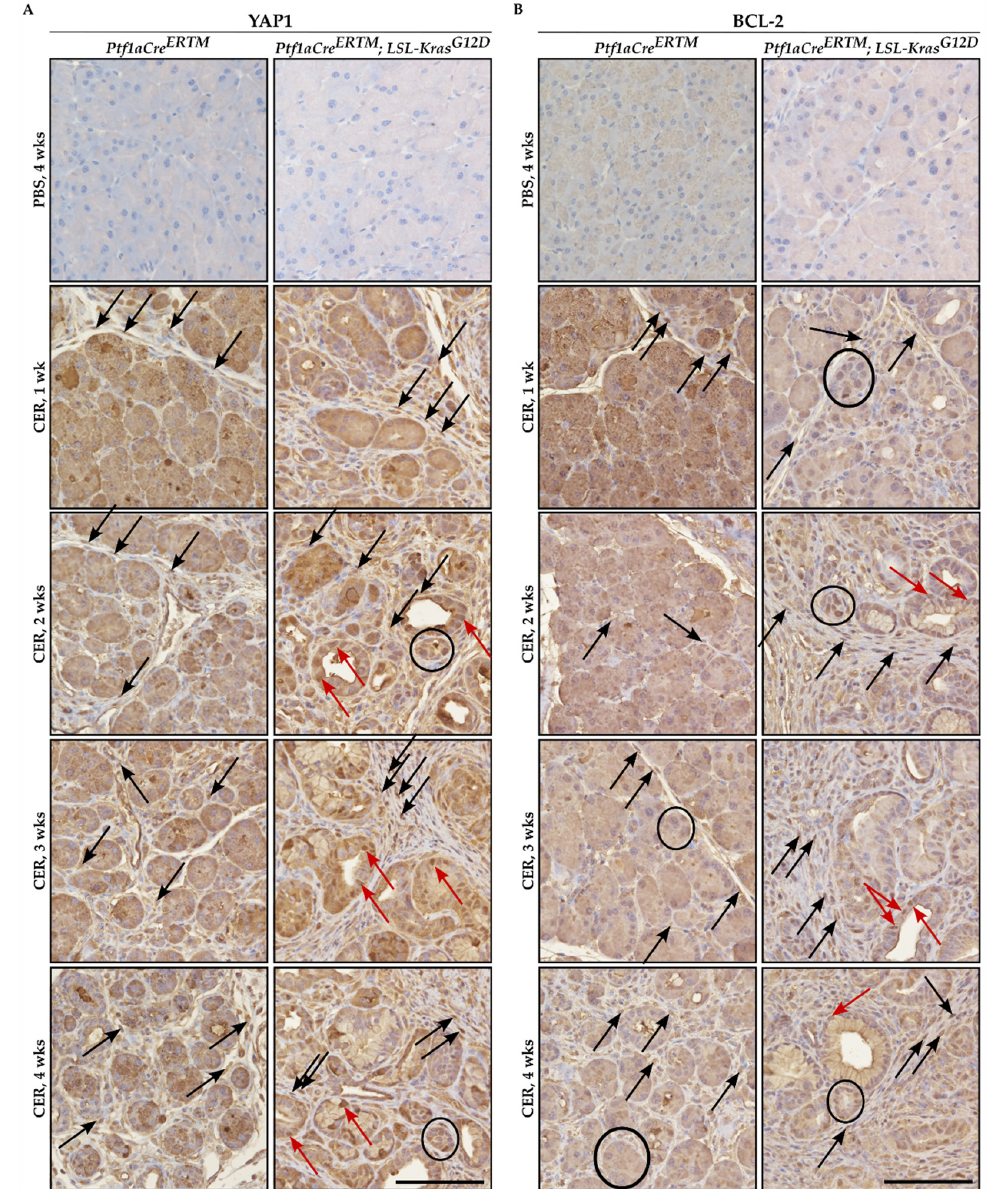
Figure 1. Immunohistochemical staining of YAP1 and BCL-2 during the development of chronic pancreatitis. Pancreatic specimens were obtained from Ptf1aCre ERTM and Ptf1aCre ERTM ;LSL-Kras G12D mice were treated with tamoxifen for one week and subsequently with PBS (vehicle) and CER (cerulein) for four weeks and samples were collected 1, 2, 3, and 4 weeks after the injury. ( A ) Immunohistochemical stain of YAP1, and ( B ) immunohistochemical stain of BCL-2. The scale bar represents 100 µm. Black arrows point to fibrotic cells, black circles mark injured pancreatic acinar cells, and red arrows mark early pancreatic neoplastic cells positive for YAP1 or BCL-2 in Figure 1A and 1B, respectively.